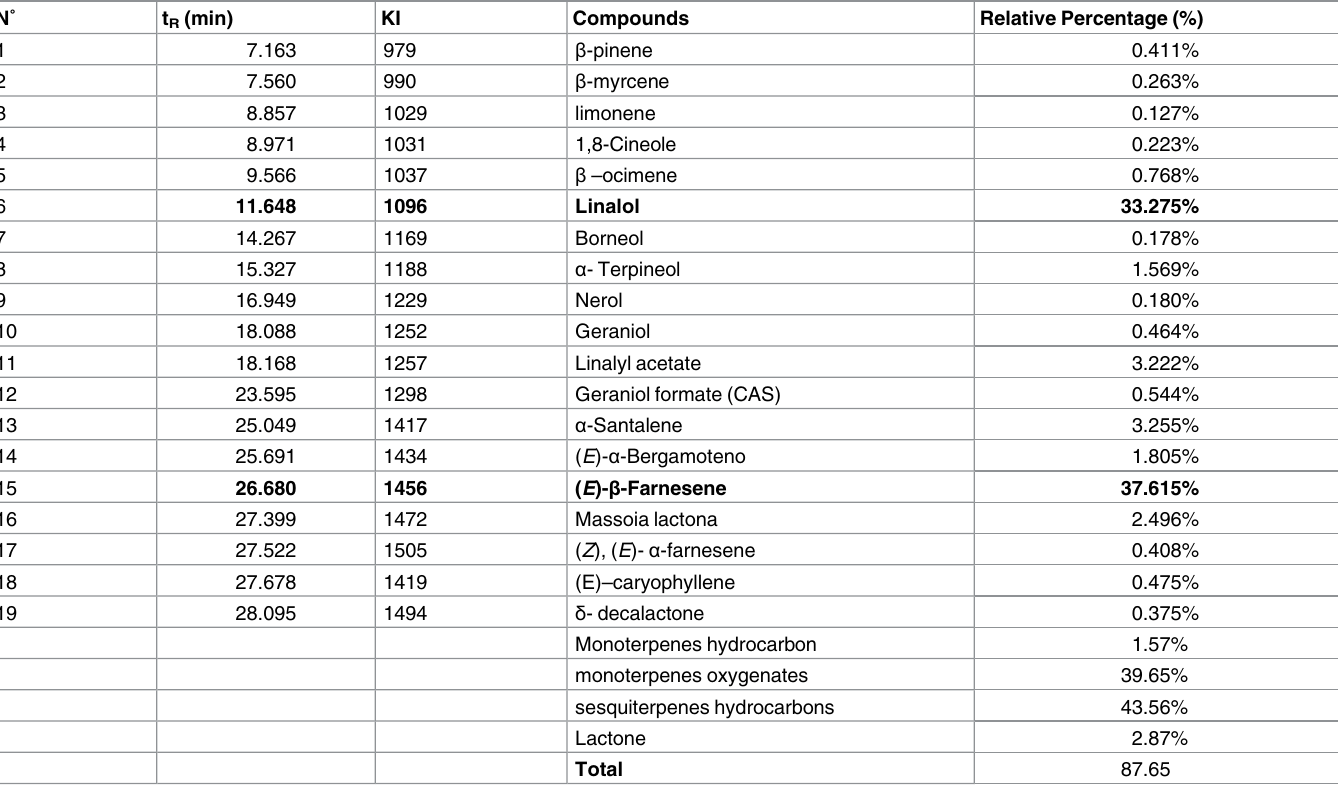
Table 1. Chemical composition of the Aeollanthus suaveolens essential